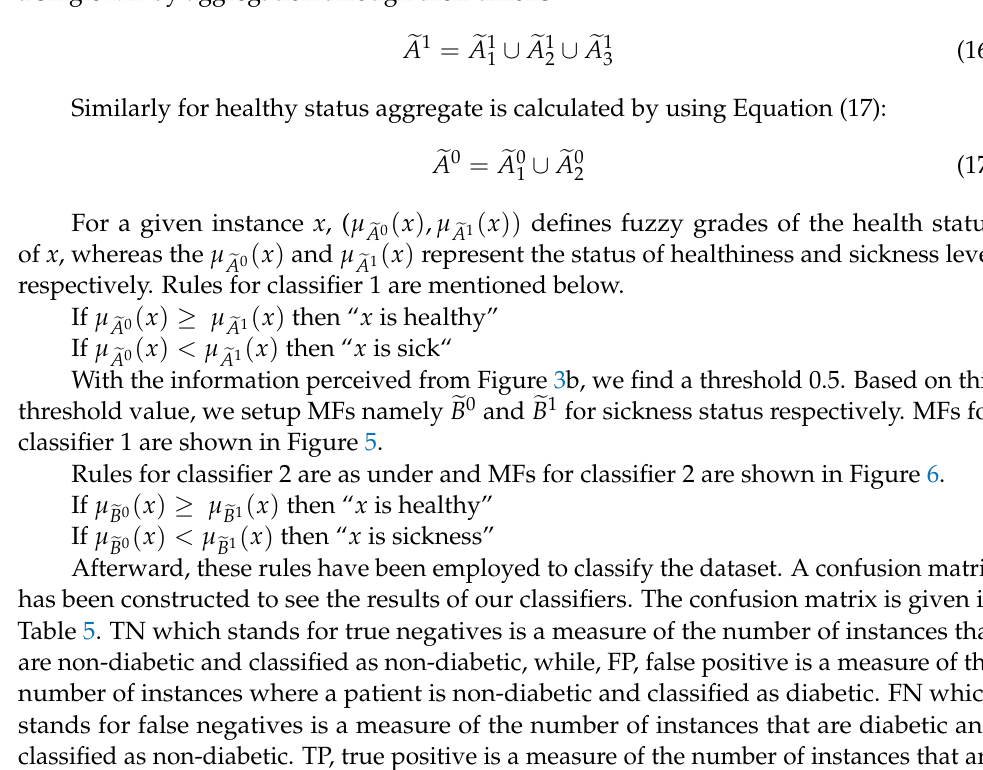
Figure 4. MFs. ( a – c ) shows MFs for class 1 while ( d , e ) shows MFs for class 2. As in Equation (16) (cid:101) A , (cid:101) A , and (cid:101) A are representing MFs for sickness, we established 2 3 1 a single MF by aggregation through their